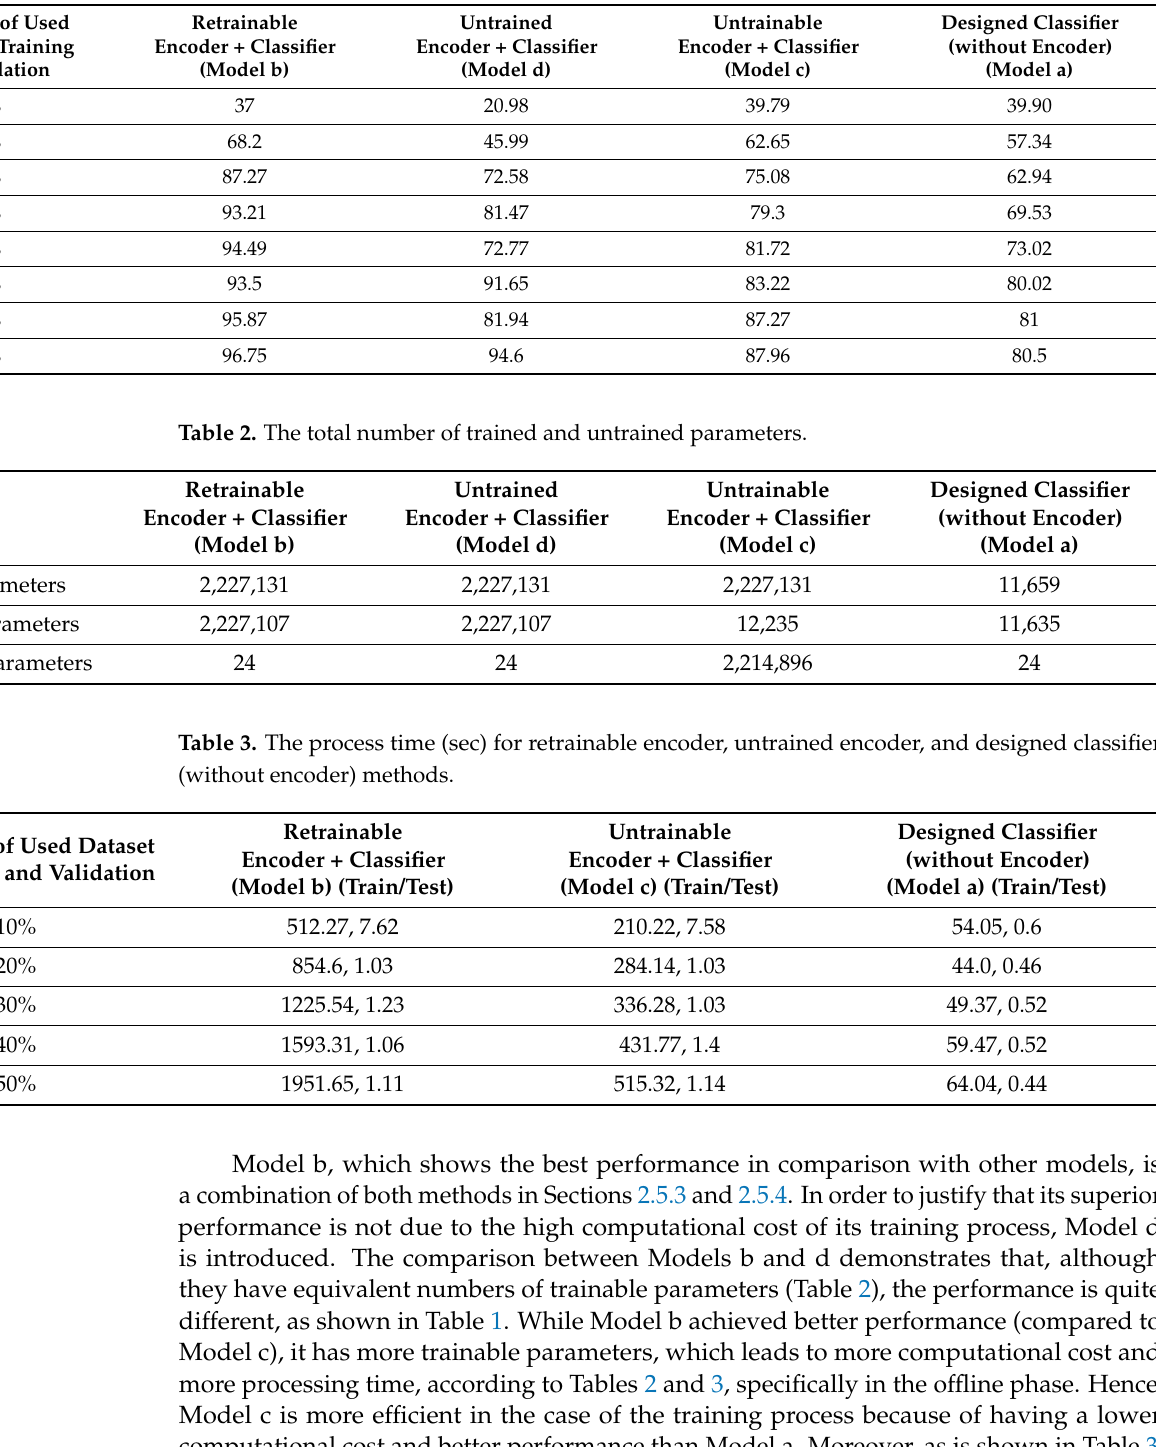
Table 1. Average accuracy comparison of proposed models using different percentages of data in case of using MIMO-AE.